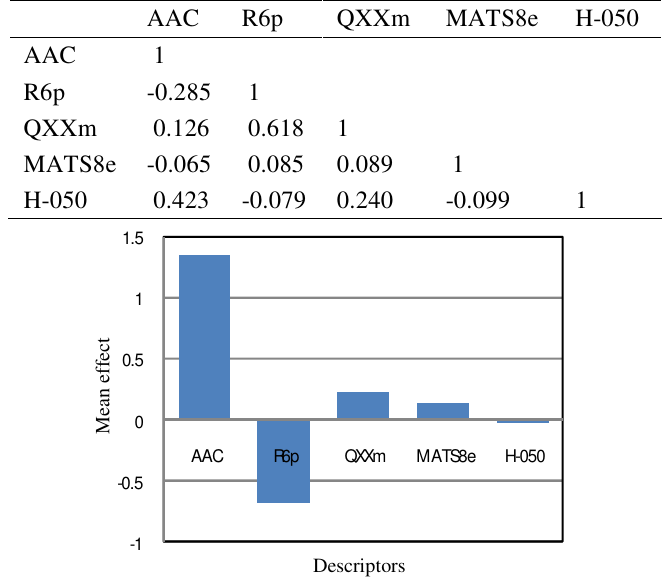
Figure 1. Plot of the mean effects of